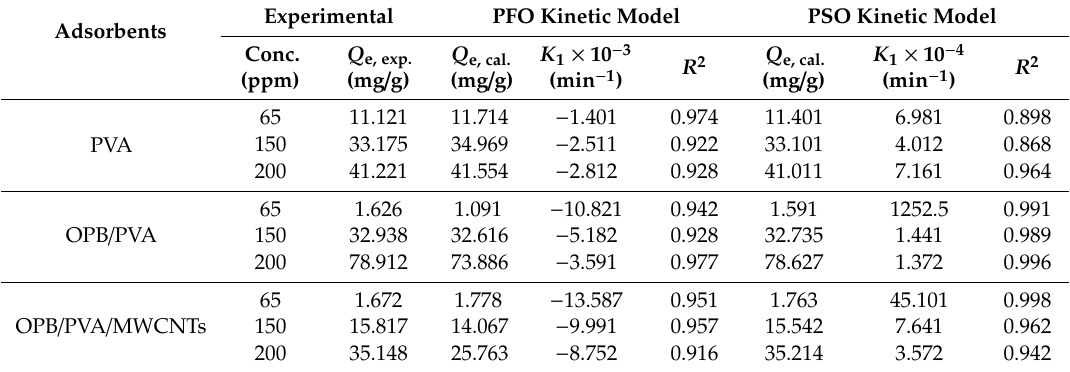
Table 3. Adsorption kinetic parameters obtained from pseudo-first-order and pseudo-second-order kinetic models using PVA, OPB / PVA and OPB / PVA / MWCNTs adsorbents. Adsorbents